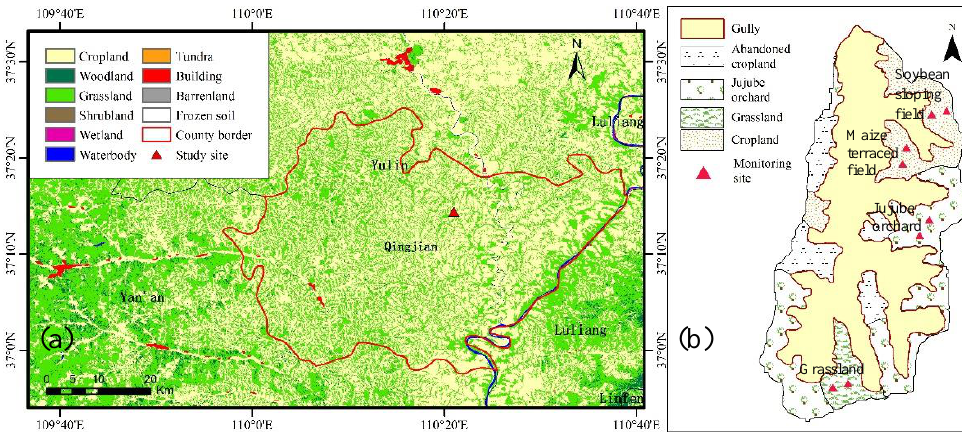
Figure 1. Land use distribution ( a ) and the locations of the four experimental sloping land uses ( b ) in the study area. The land use data were obtained from the global land cover with 30 m resolution (GlobalLand30) for the year 2010, produced by National Geomatics Center of China (http://www.globallandcover.com/GLC30Download/index.aspx).